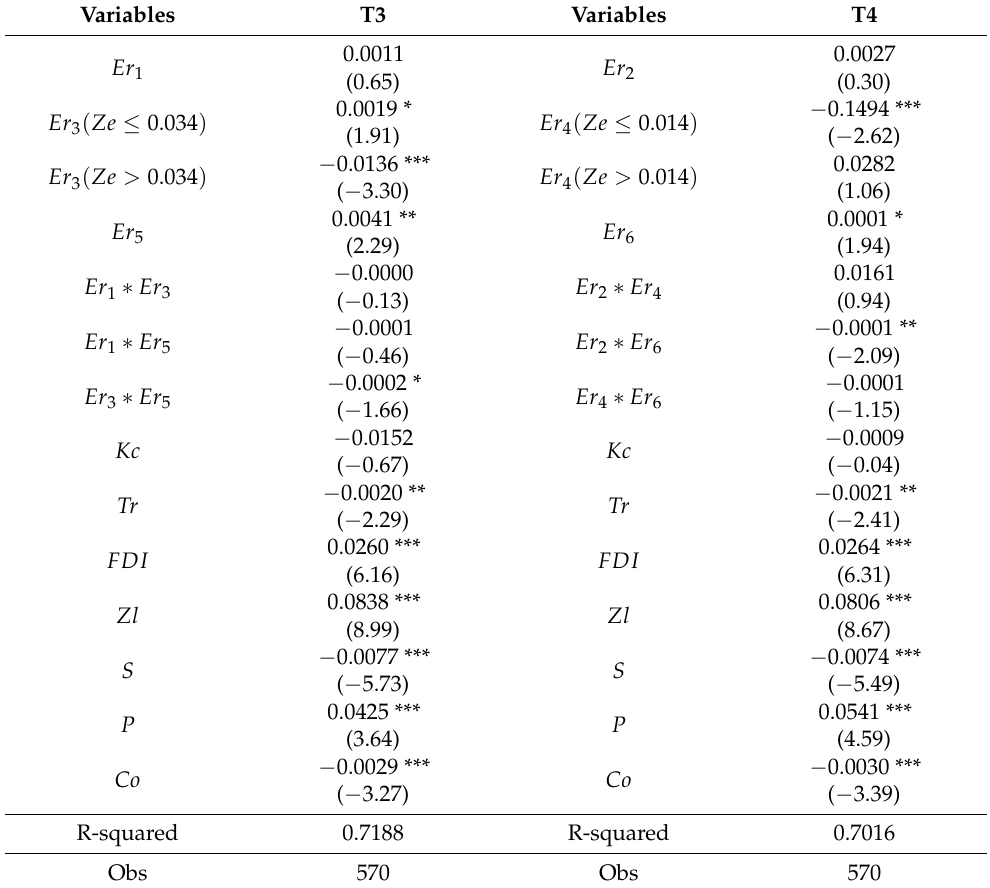
Table 9. Threshold regressions of market environmental regulations: